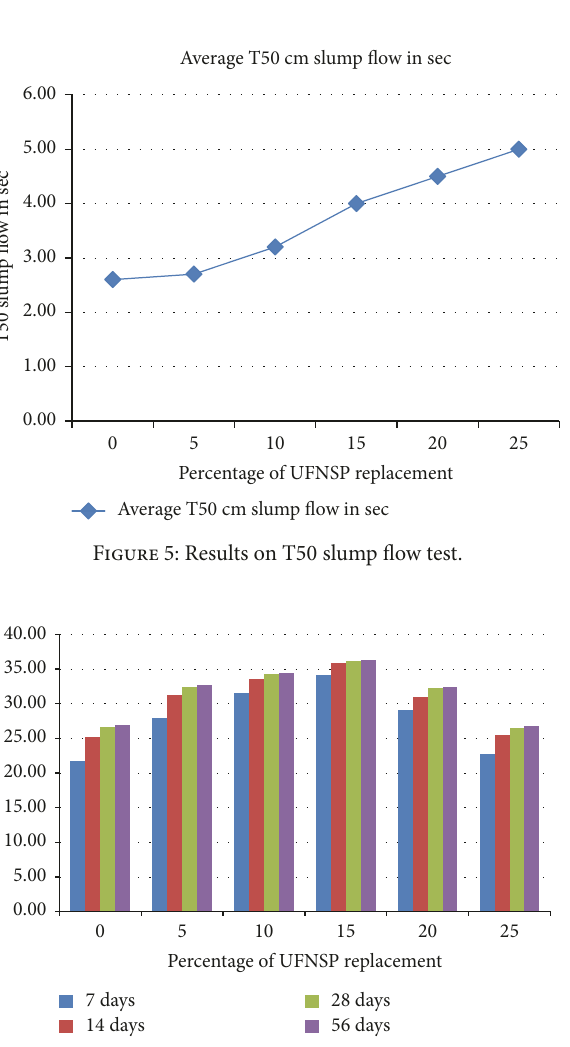
Figure 6: Results on average compressive strength test on 28